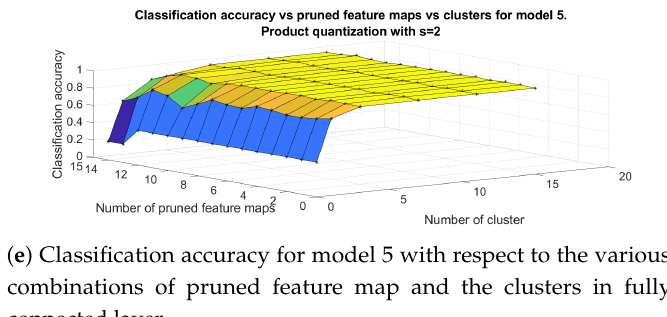
Figure 9. Classification accuracy for models in Table 1 for the approach that include filter pruning and product quantization with s =